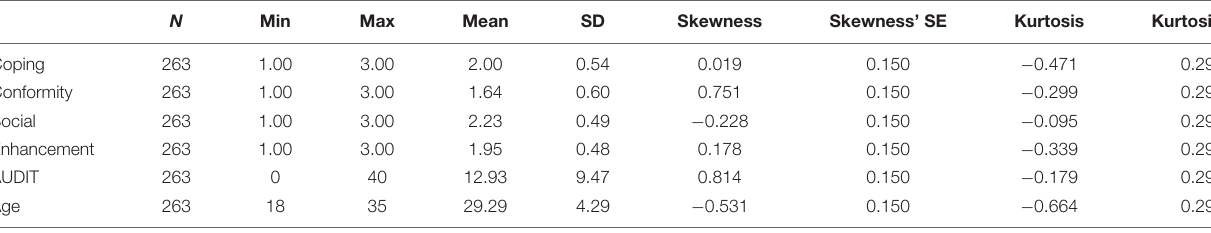
TABLE 2 | Descriptive statistics for motives, Alcohol Use Disorder Identification Test (AUDIT), and age in the total sample.